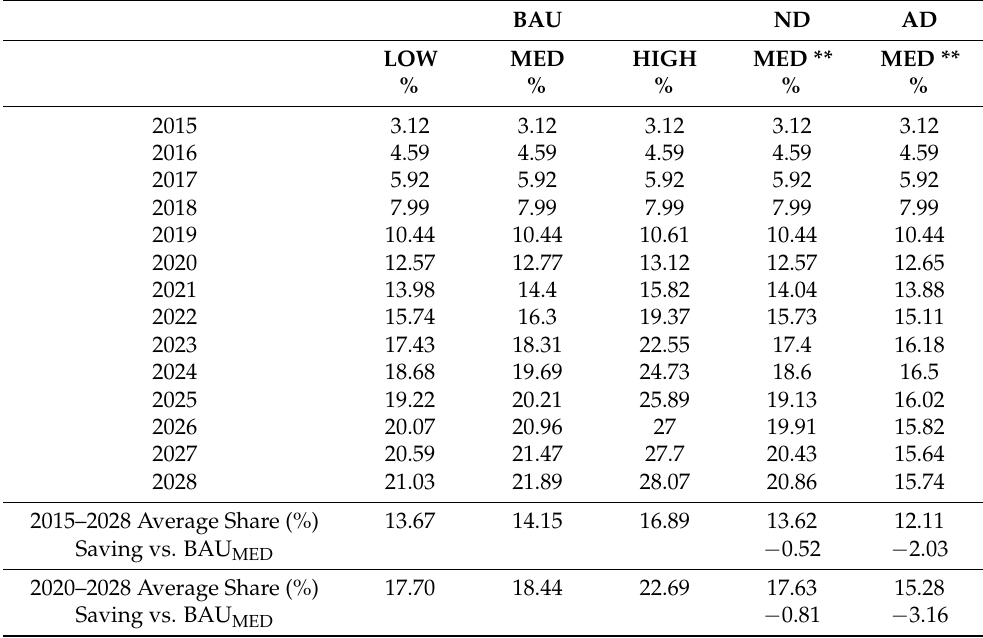
Table 3. Data centre share of national electricity demand.